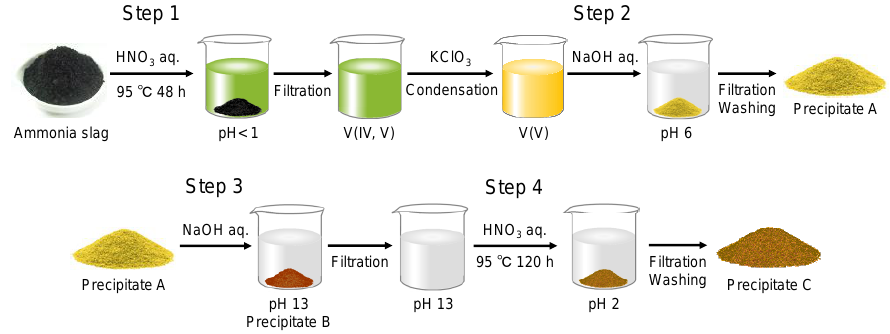
Table 1. Chemical composition of the ash content of ammonia slag. Element